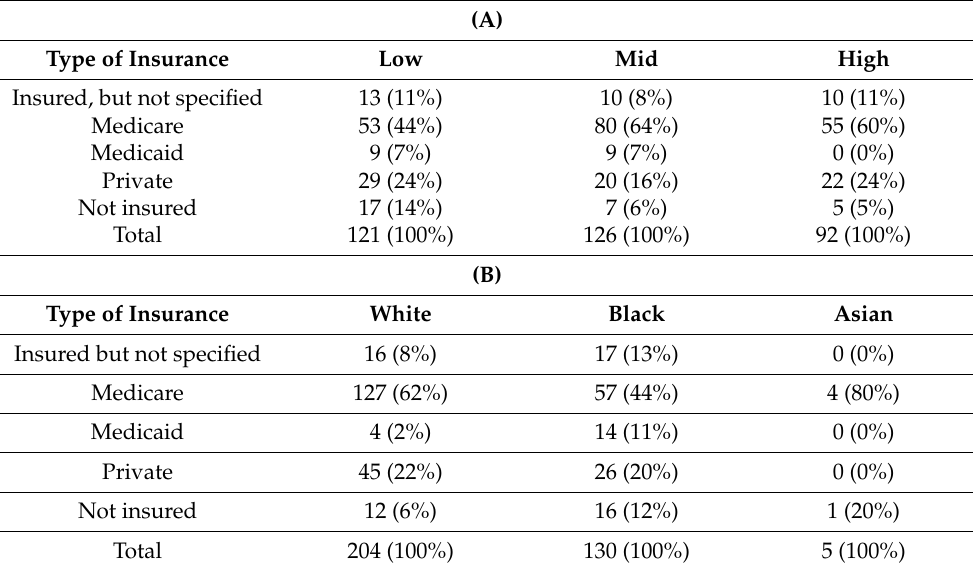
Table 5. ( A ) Insurance and SES. Distribution of the subjects based on the type of insurance and SES. A comparative statistic for nominal data (counts) was used to detect significant differences between group (chi-square and p = 0.007). The data indicate that there is a significant difference between SES groups and type of insurance. ( B ) Insurance and race. Distribution of the subjects based on the type of insurance and race. A comparative statistic for nominal data (counts) was used to detect significant differences between group (chi-square p = 0.001). The data indicate that there is a significant difference between race and type of insurance.